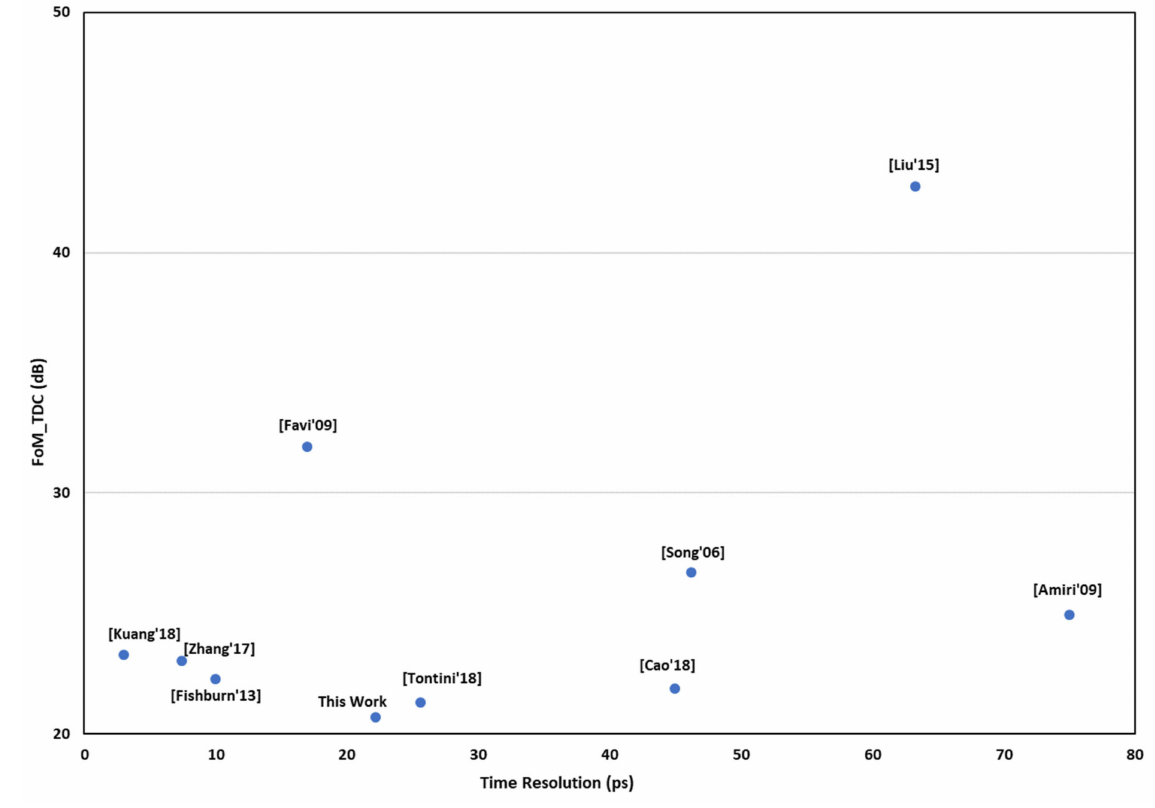
Figure 13. Comparison of